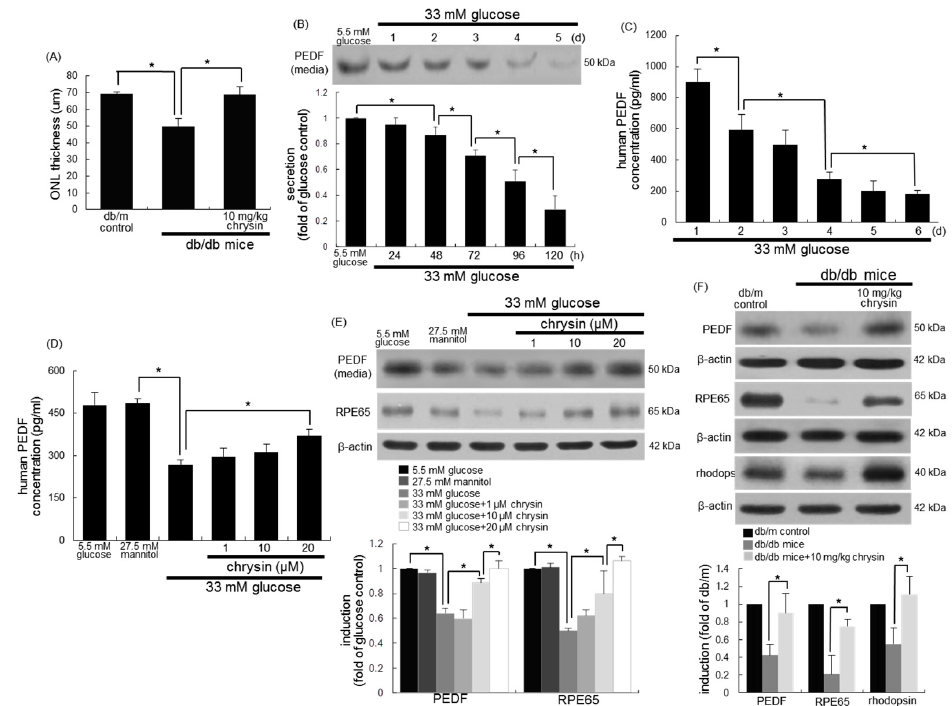
Figure 2. Restoration of outer nuclear layer (ONL) thickness ( A ), time course responses of production of pigment epithelium-derived factor (PEDF) by glucose ( B , C ) and the induction of PEDF, RPE65, and rhodopsin by chrysin ( D – F ). Human retinal pigment epithelial (RPE) cells were incubated with 33 of mM glucose in the absence and presence of 1–20 μ M chrysin for up to 6 days. Cells were also incubated with 5.5 mM of glucose and 27.5 mM of mannitol as osmotic controls. The db/db mice were orally supplemented with 10 mg/kg of chrysin daily for 10 weeks. The db/m mice were introduced as control animals. The secretion of PEDF was measured with ELISA kits ( C , D ). Culture media, cell lysates, and retinal tissue extracts were subject to Western blot analysis with a primary antibody against PEDF, RPE65, and rhodopsin ( B , E , F ). β -actin protein was used as a cellular internal control for RPE cells. Bar graphs (mean ± SEM, n = nine independent experiments) in the bottom panels represent the densitometric results of upper blot bands. *, values in bar graphs indicate significant different at p < 0.05.